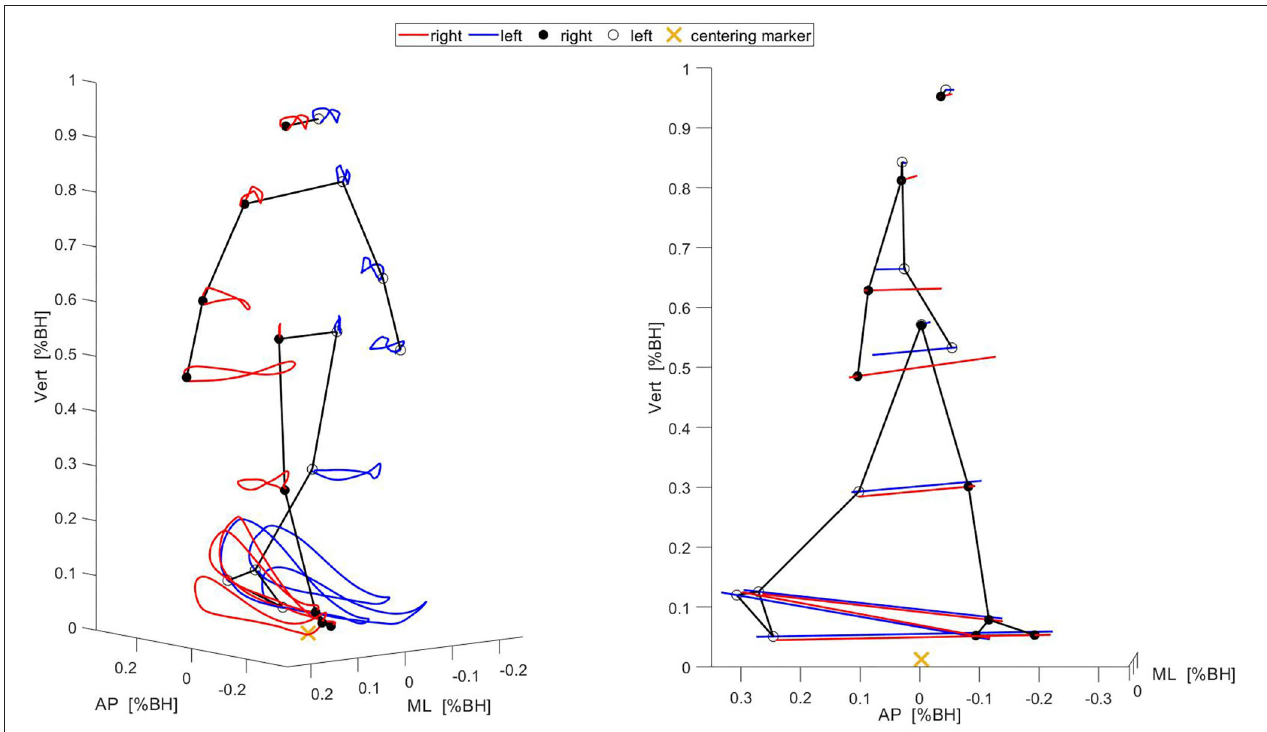
FIGURE 1 | Illustration of the full movement (Left) and the first kSYN (Right) of one gait cycle while the participant walked in a straight line. The stick figures show the marker positions at the beginning of the gait cycle. The red and blue lines show the marker trajectories over the whole gait cycle. AP, anterior-posterior; ML, medial-lateral; Vert, vertical; BH, body